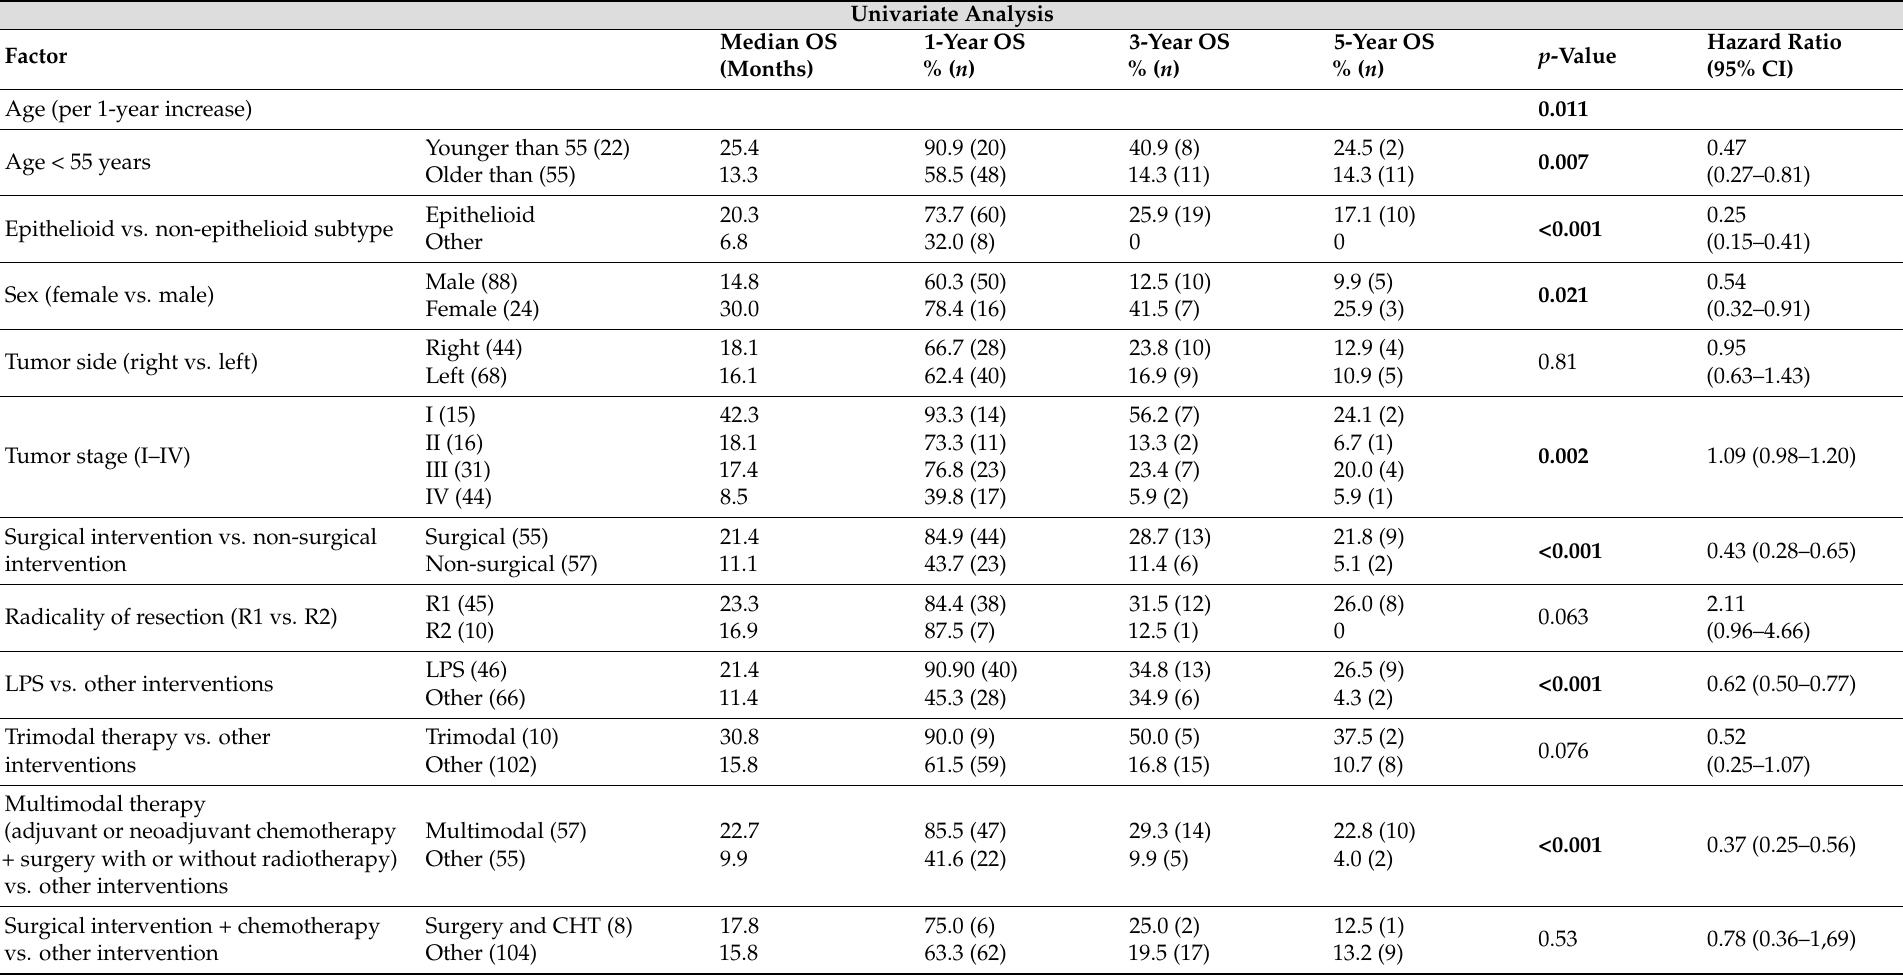
Table 5. Analysis of the factors of possible prognostic significance in our cohort, as determined by univariate Cox regression. CD cardiac decompensation, CI confidence interval, CHT chemotherapy, LPS lung-preserving surgery, OS overall survival, PE pulmonary edema, RCC red cell concentrate; statistically significant p -values were printed in